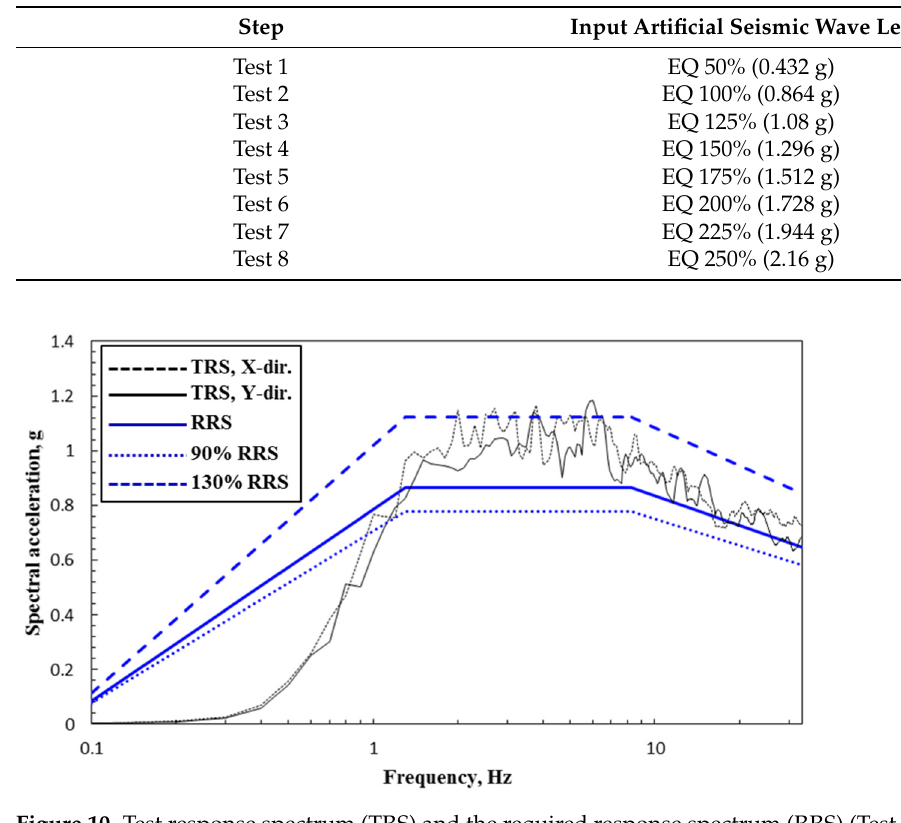
Figure 10. Test response spectrum (TRS) and the required response spectrum (RRS) (Test 2, 0.864 g, A1, SDB-2 specimen).